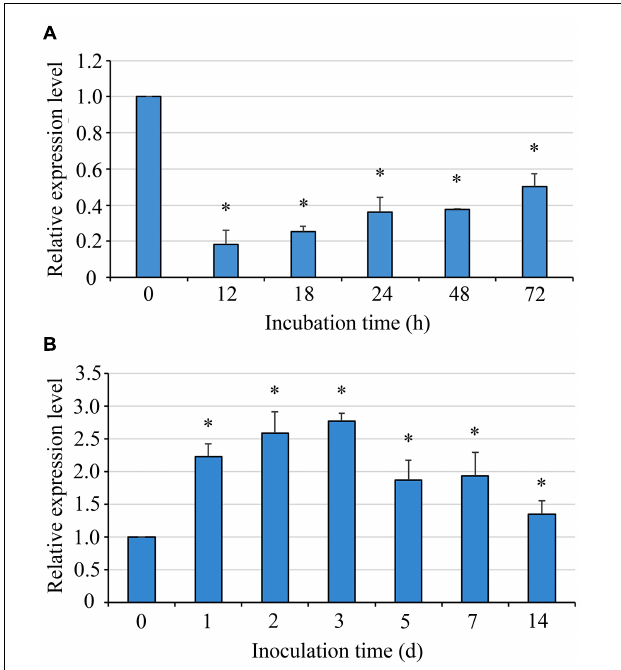
FIGURE 1 | The mRNA level of Uvsun1 in the wild type strain P1 during conidia germination and rice infection. (A) Levels of Uvsun1 mRNA in the wild type strain P1 during conidia germination. Conidia were incubated on cellophane on YTA medium. Samples were taken at 12, 18, 24, 48, and 72 hpi. Data are relative to the mRNA levels in ungerminated conidia. (B) Levels of Uvsun1 mRNA following the inoculation of rice panicles with P1 at various days after inoculation (dpi). Data are relative to the mRNA levels in mycelium before inoculation. Results are expressed as mean ± SD of three technical replicates. Asterisks indicate significant differences (one-way ANOVA, ∗ p <